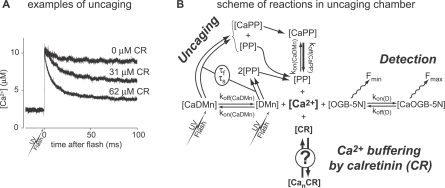
Ca2+ Measurements In Vitro(A) Examples of changes in free [Ca2+] after photolysis of DMn in the absence of protein (upper trace) and in the presence of 31 μM and 62 μM CR (middle and lower traces, respectively). The UV flash energies used to uncage DMn were of similar magnitude, resulting in an equivalent amount of uncaged Ca2+.(B) Scheme of all equilibrium reactions occurring in the measurement chamber after photolysis of caged Ca2+. The kinetic rate constants for DMn, its photoproducts (PP), and the Oregon Green BAPTA 5N (OGB-5N), and uncaging time constants (τf and τs) of DMn were independently determined. The reaction parameters to be determined for describing the Ca2+ binding to CR are indicated by a question mark (?).